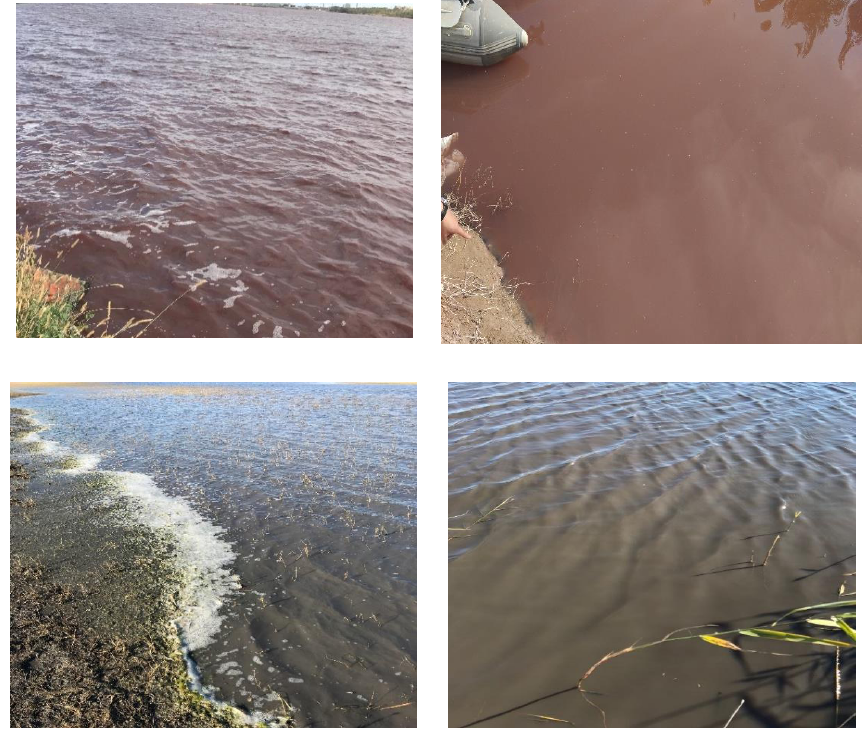
Figure 1. Illustrations of water colour anomalies.